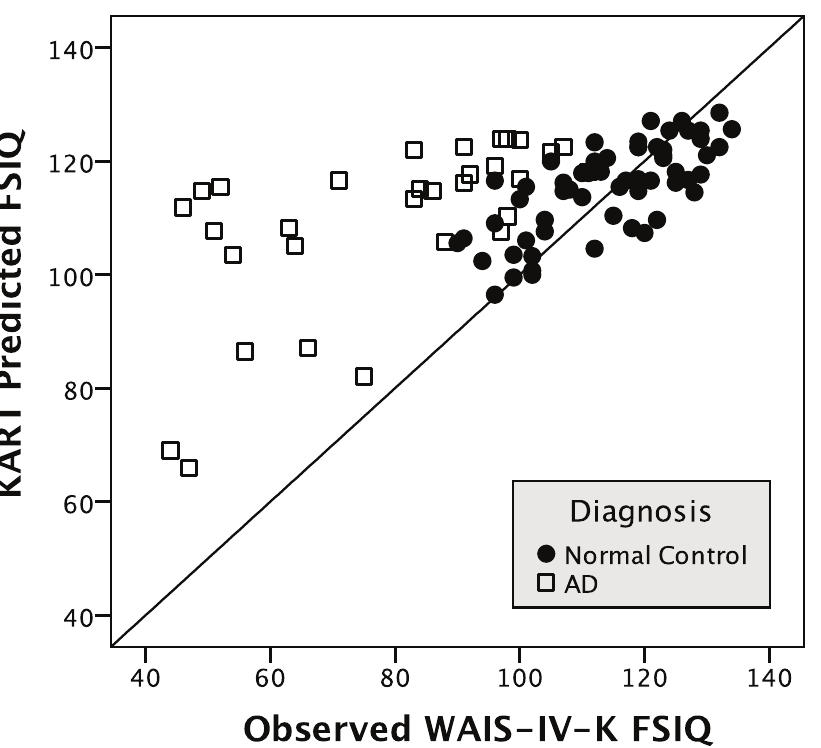
Fig 1. Distribution of Korean Adult Reading Test (KART)-predicted full-scale IQ (FSIQ) and observed FSIQ.